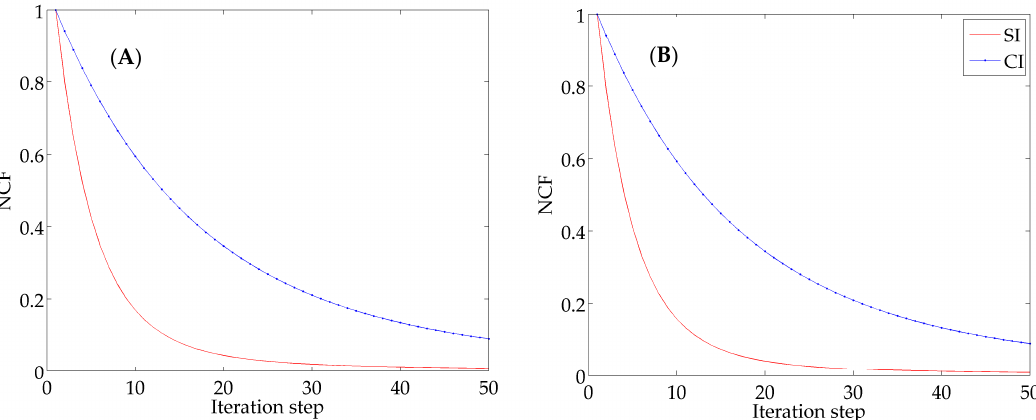
Figure 3. The descending curves of the normalized cost function (NCF) using two interpolation methods in IE1 ( A ) and IE2 ( B ). Table 2. The results of the quantitative metrics using two interpolation methods in the idealized twin experiment 1 (IE1).